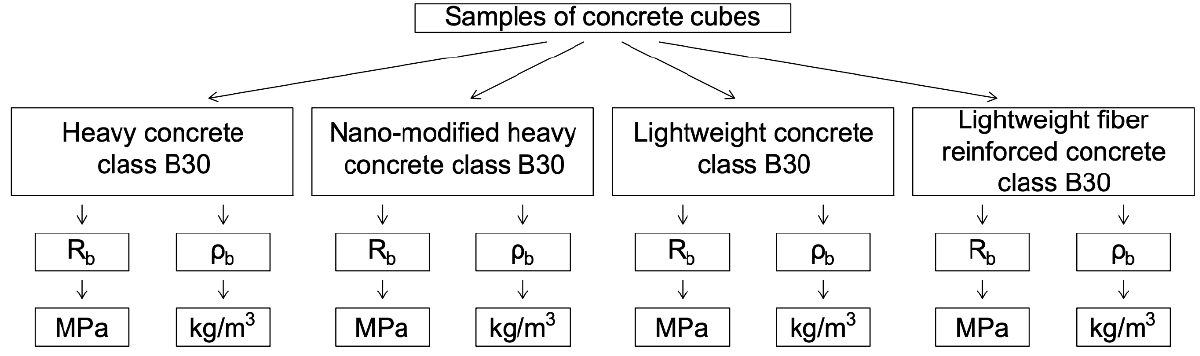
Figure 5. Plan of the physical experiment.